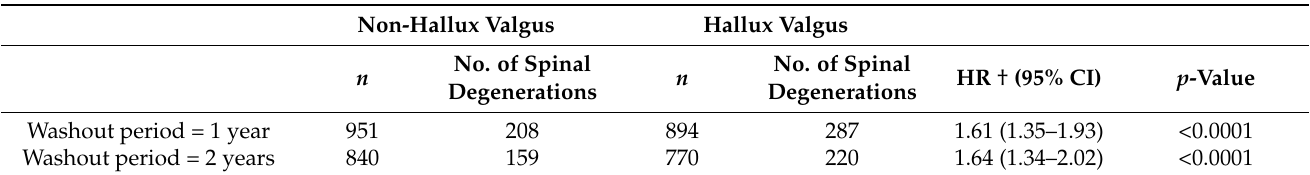
Table A3. Sensitivity analysis with 1 and 2 year washout